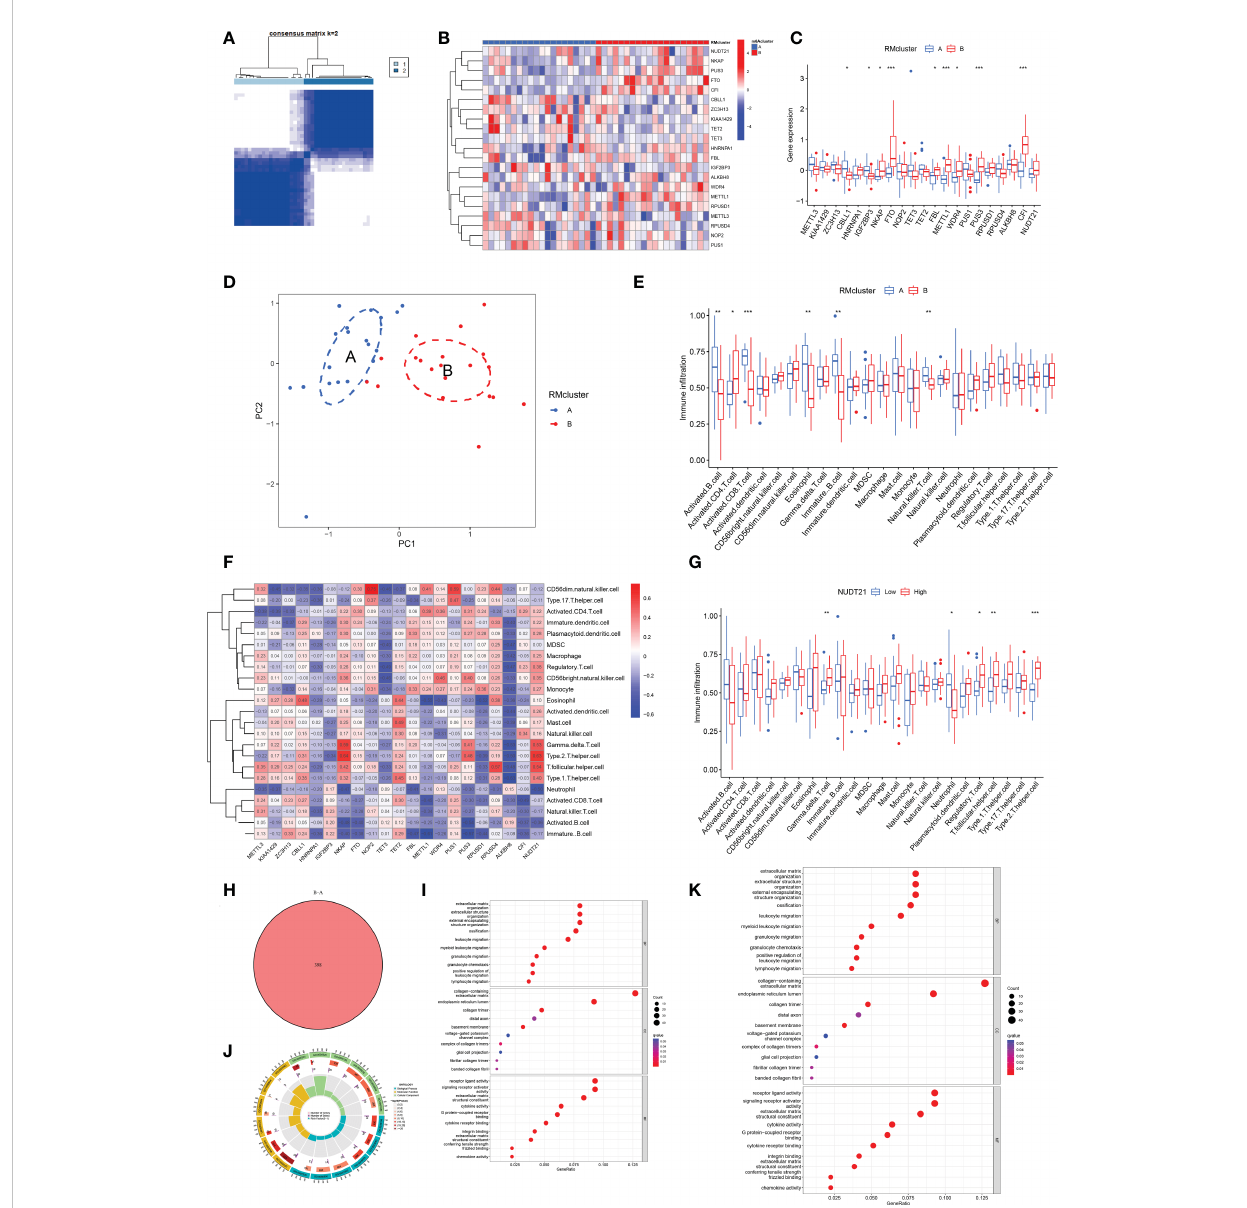
FIGURE 4 Identi fi cation of two distinct RM clusters, immune cell in fi ltration, and GO and KEGG pathway enrichment analyses. (A) Consensus clustering matrix of OA samples for k=2. The OA patients were divided into two clusters: RM clusters A and B. (B, C) Boxplot (B) and heat map (C) showing differential gene expression in the two RM clusters. (D) PCA was used to verify the two distinct RM clusters. (E) Box plot showing the in fi ltrating immune cells in the two RM clusters. (F) Heat map of the correlation between the expression of the 21 RNA modi fi cation regulators and immune cells in fi ltration by the ssGSEA method. (G) WDR4 was negatively correlated with activated B cells (P<0.05), immature B cells (P<0.05) and eosinophils (P<0.01) and positively related to activated CD4 + T cells (P<0.05) and CD56 bright natural killer cells (P<0.05). (H) Venn diagram showing 398 differential genes between the two RM clusters. (I) Bubble diagram showing the top 10 terms of GO categories for BP, MF and CC. (J) The circlize diagram showing GO term analysis for BP, MF and CC. The fi rst lap indicates the top 10 GO terms; the number of genes corresponds to the outer lap. The second lap indicates the number of genes in the genome background and P values for enrichment of the differential genes for the speci fi ed BP, MF and CC terms. The third lap indicates the number of selected genes for each GO term. The fourth lap indicates the enrichment factor for each GO term. (K) Bubble diagram showing KEGG enrichment analysis of differential genes between the two RM clusters. (for all fi gures, * represents p <0.05, ** represents p <0.01 and *** represents p <0.001) RM, RNA modi fi cation; OA, osteoarthritis; PCA, principal component analysis; GO, gene ontology; KEGG, Kyoto Encyclopedia of Gene and Genome; BP, biological process; MF, molecular function; CC, cellular